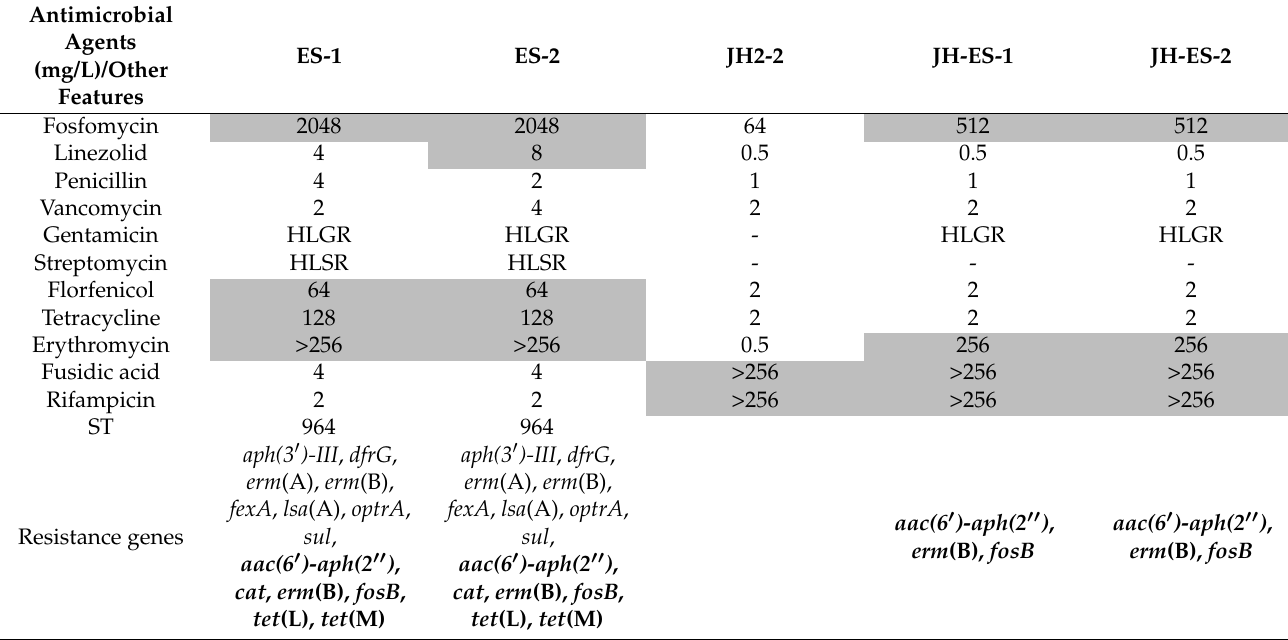
Note: MICs shaded grey represented strains that were resistant to the corresponding antimicrobial agents; Antimicrobial resistance genes located on plasmids were shown in bold. HLGR, high-level gentamicin resistance; HLSR, high-level streptomycin resistance; –, not HLGR/HLSR. MICs of gentamicin and streptomycin > 500 ug/ml and 2000 ug/ml were defined as HLGR and HLSR, respectively, based on the